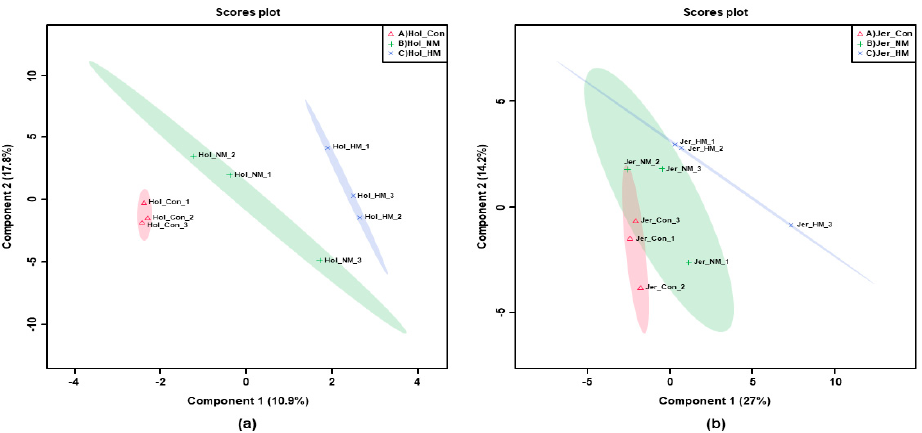
Figure 4. PLS − DA analyses for the serum metabolites of Holstein ( a ) and Jersey ( b ) steers supplemented with different concentration of minerals. Con: only TMR (without mineral supplementation), NM: TMR + NRC recommended concentration of mineral supplementation (Se 0.1 ppm + Zn 30 ppm + Cu 10 ppm)/kg DM and HM: TMR + higher than recommended concentration of mineral